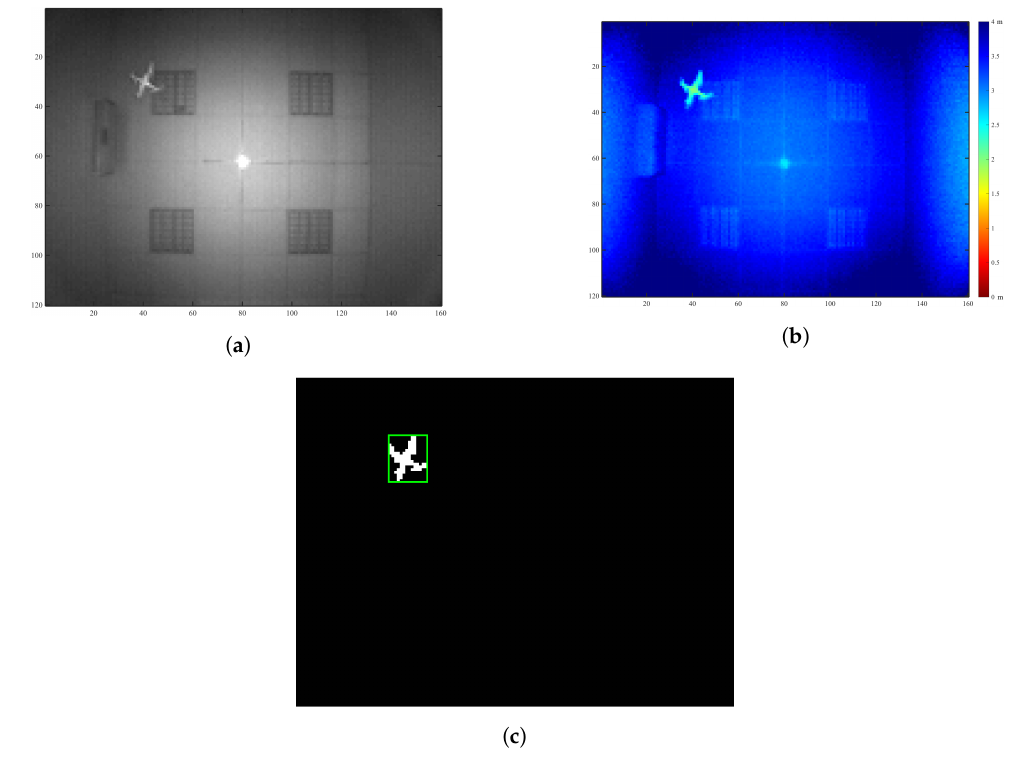
Figure 6. Images from the TOF camera. The configuration has been chosen so as to reach all possible distances in a proper way, as can be appreciated. In this case, the drone flew approximately 1.9 m from the lens. ( a ) Image of amplitudes, ( b ) Image of distances, ( c ) Drone recognition after subtracting the